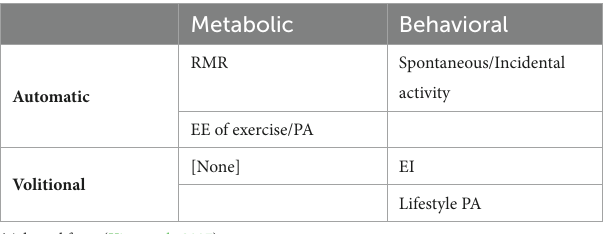
TABLE 1 Metabolic and behavioral compensatory responses as varying by automaticity and volitional behavior *